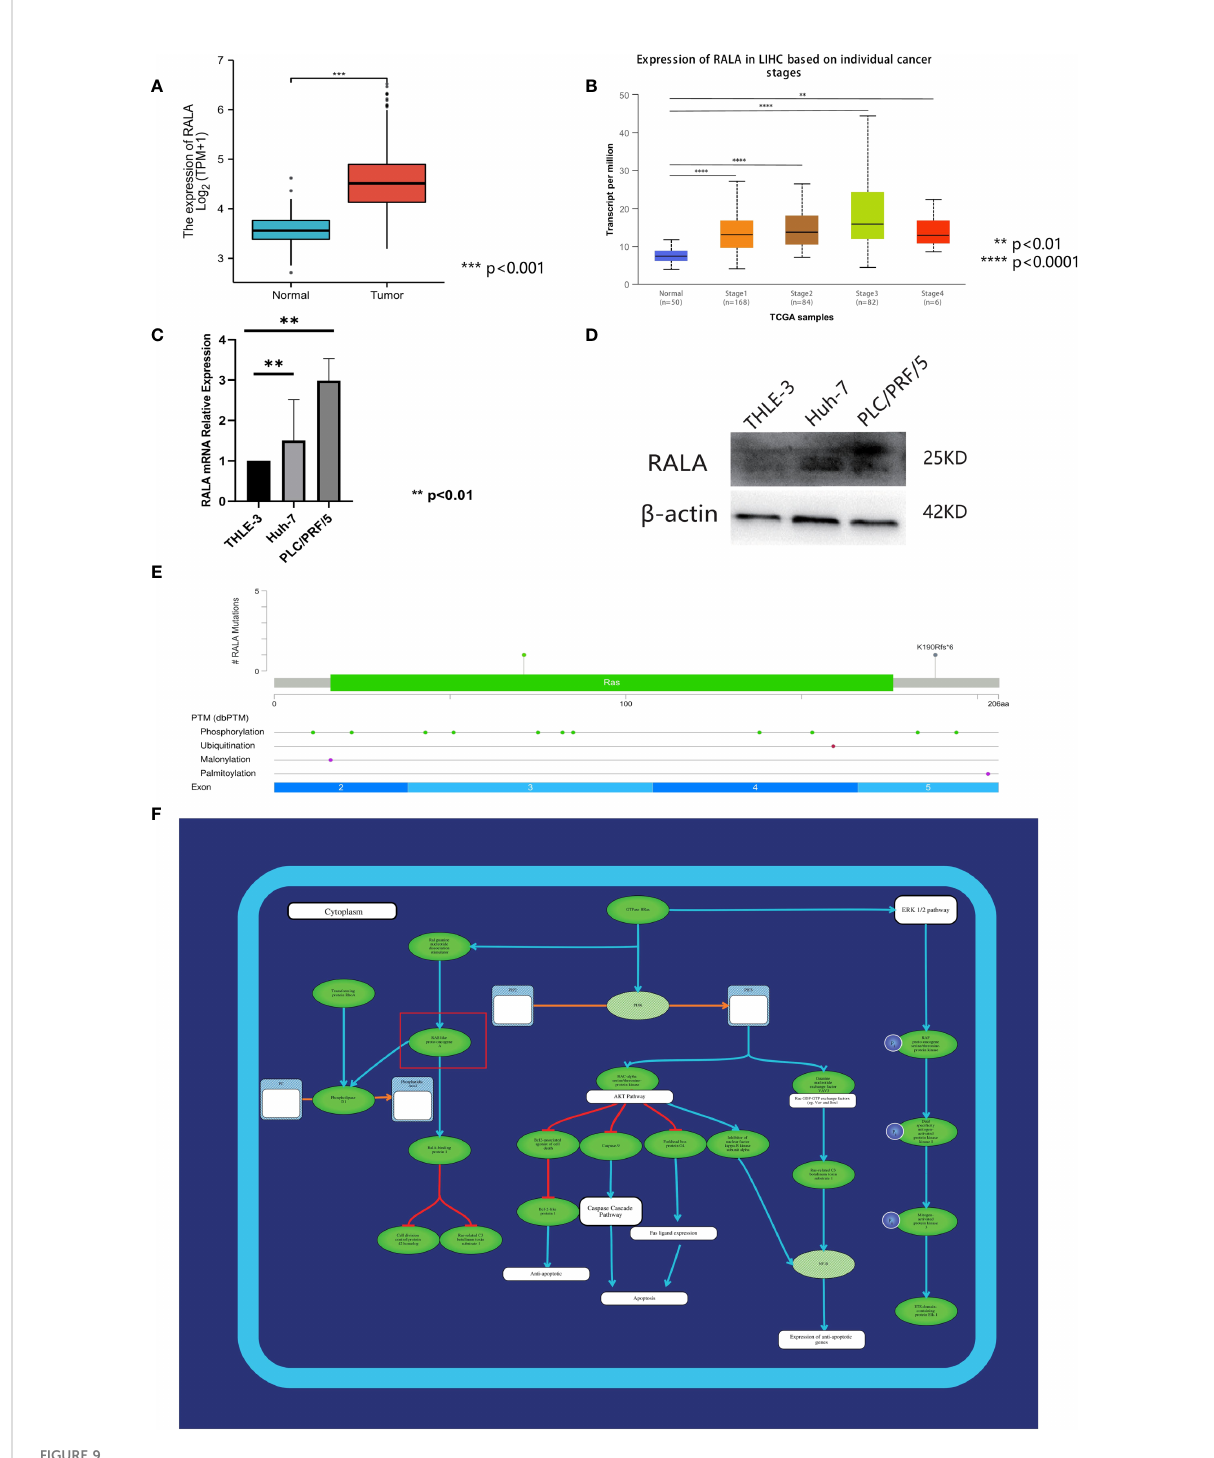
FIGURE 9 Analysis of RALA in HCC. (A) The expression level of RALA was predicted by TCGA database to be signi fi cantly higher in HCC tumor tissues. (B) The expression of RALA in different stages of HCC. (C) The protein expression level of RALA in HCC cell lines. (D) The mRNA expression level of RALA in HCC cell lines. Compared with THLE-3, the expression level of RALA was up-regulated in HCC cell lines. (E) Mutations and CNA data of RALA in HCC. (F) Signaling pathways containing RALA. **p < 0.01, ***p < 0.001, ****p <